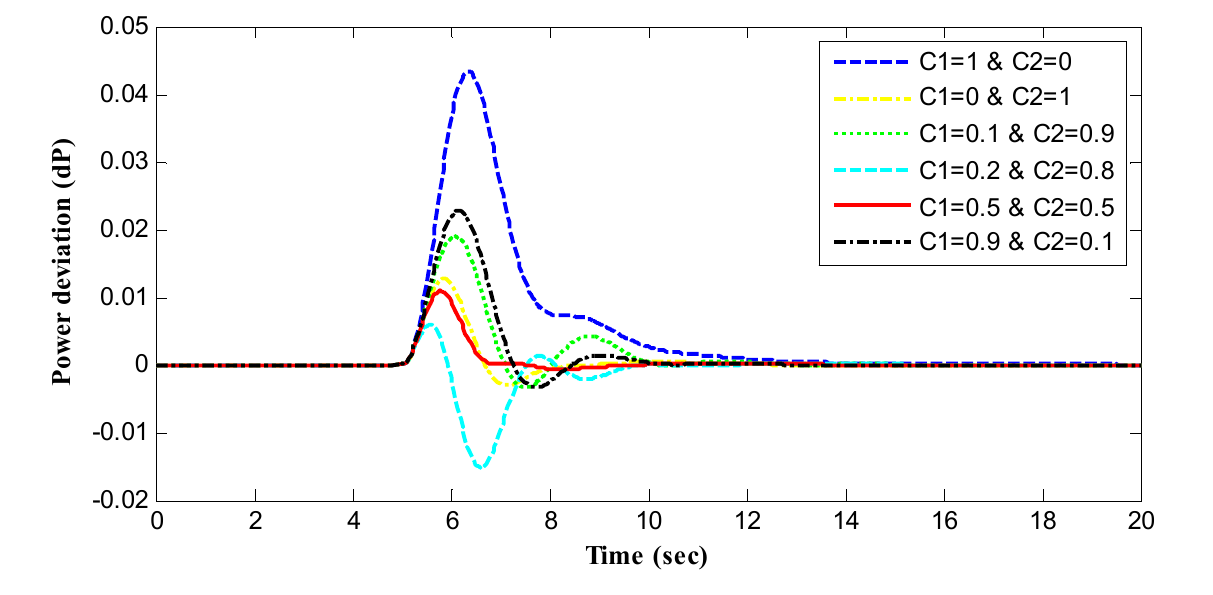
Figure 11. Power deviation ∆𝑃 using the proposed IB-WGFF. Table 5. System efforts using DA-FOPID controller via the proposed